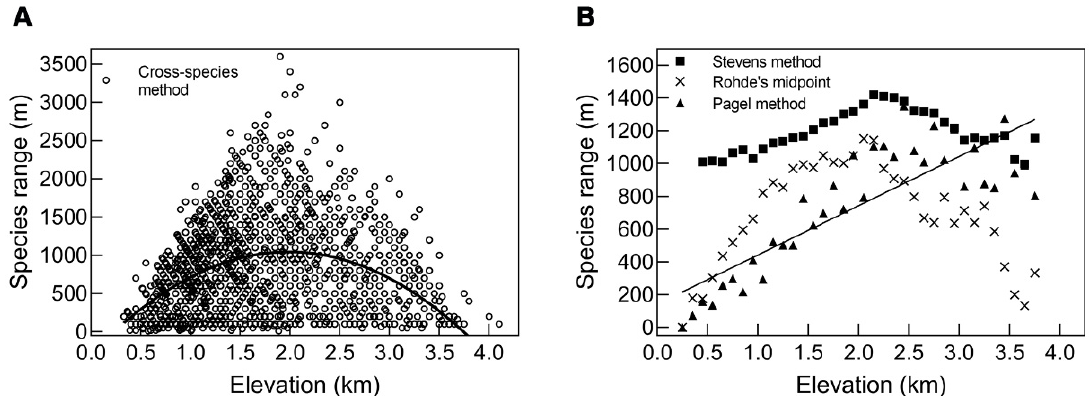
Figure 6. ( A ) The altitudinal patterns of species range in cross-species method. ( B ) The altitudinal patterns of species range in Stevens methods, Rohde’s midpoint method, and Pagel’s